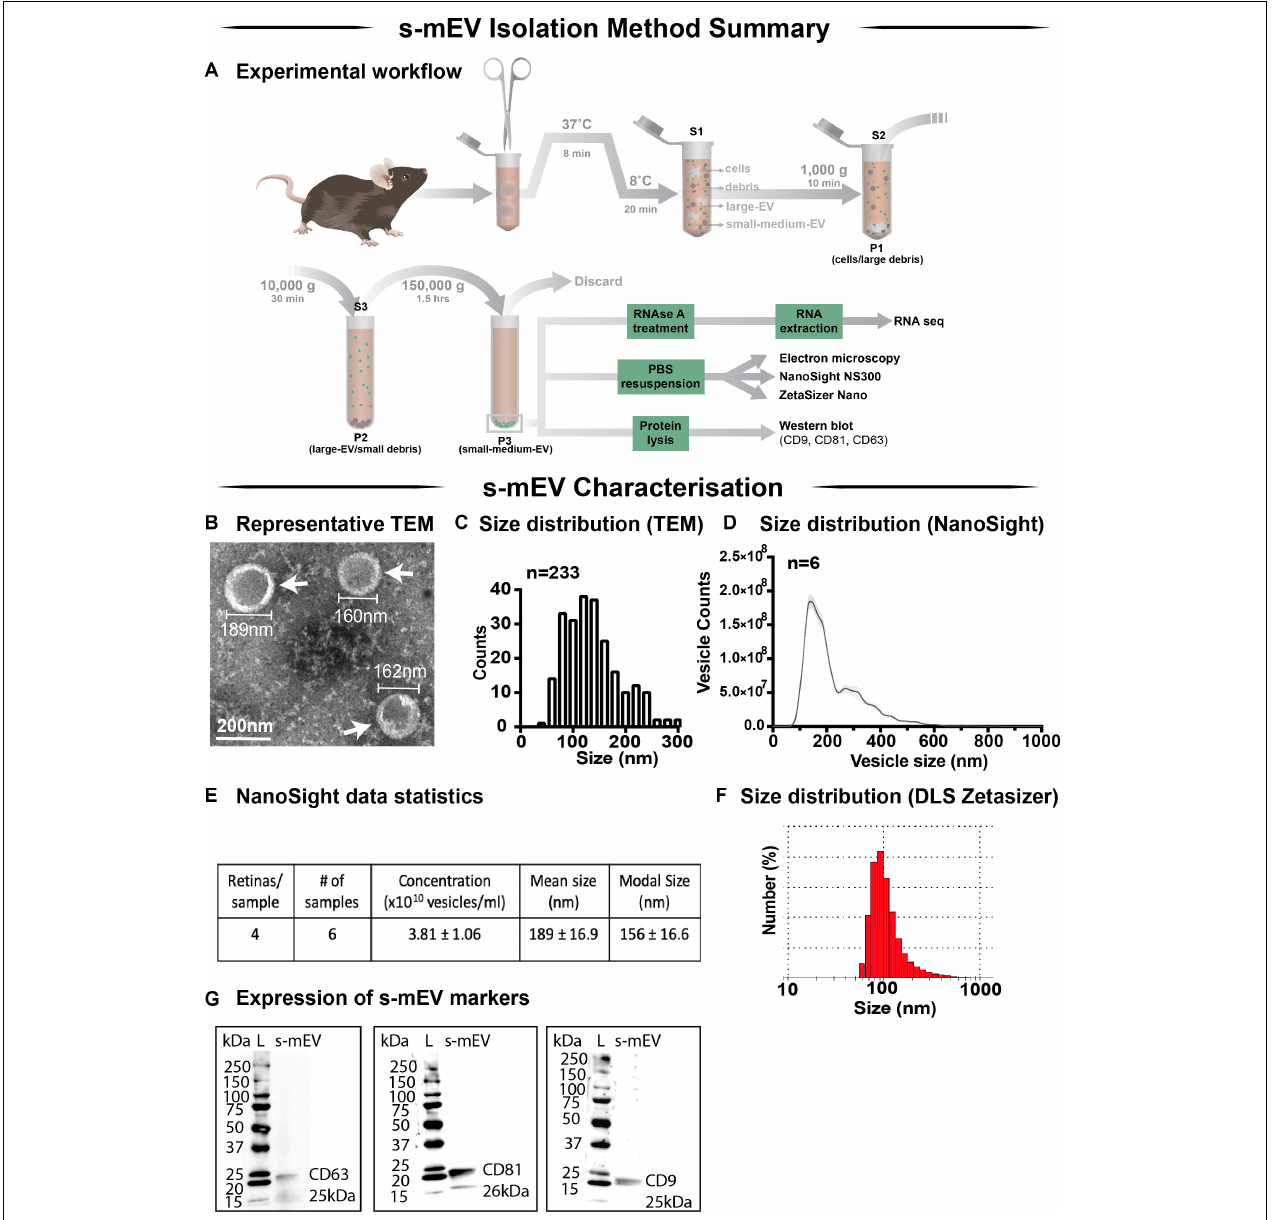
FIGURE 1 | Retinal s-mEV isolation and characterization. (A) Workflow for the isolation and characterization of retinal s-mEV. s-mEV were isolated from papain-digested retinas using differential ultracentrifugation. s-mEV pellets (P3) were processed for RNA extraction and RNA sequencing (RNA seq) and size and morphology analysis by electron microscopy, NanoSight NS300 and Zetasizer Nano. s-mEV pellets were also digested in protein lysis buffer and analyzed for the expression of s-mEV markers CD9, CD81, and CD63 by western blot. S, supernatant; P, pellet. (B) Representative Transmission Electron Microscopy (TEM) micrograph showing isolated retinal vesicles (white arrows) with consistent round, cup-shaped morphology and size of s-mEV. (C) Diameter distribution of retinal s-mEV measured from TEM micrographs ( n = 233). (D) Size distribution of retinal s-mEV ( n = 6 samples, 4 retinas/sample) using nanotracking analysis performed on a NanoSight NS300. (E) Average concentration, mean and modal size of s-mEV isolated from mouse retinas measured by nanotracking analysis ( n = 6 samples, 4 retinas/sample). (F) Representative plot of the size distribution of s-mEV measured by dynamic light scatter (DLS) using a Zetasizer Nano instrument ( n = 5). (G) Full-length western blots showing the presence of s-mEV markers CD63 (25 kDa), CD9 (26 kDa), and CD81 (25 kDa) in retinal s-mEV protein lysates. Molecular weight standard (L). Scale bar = 200